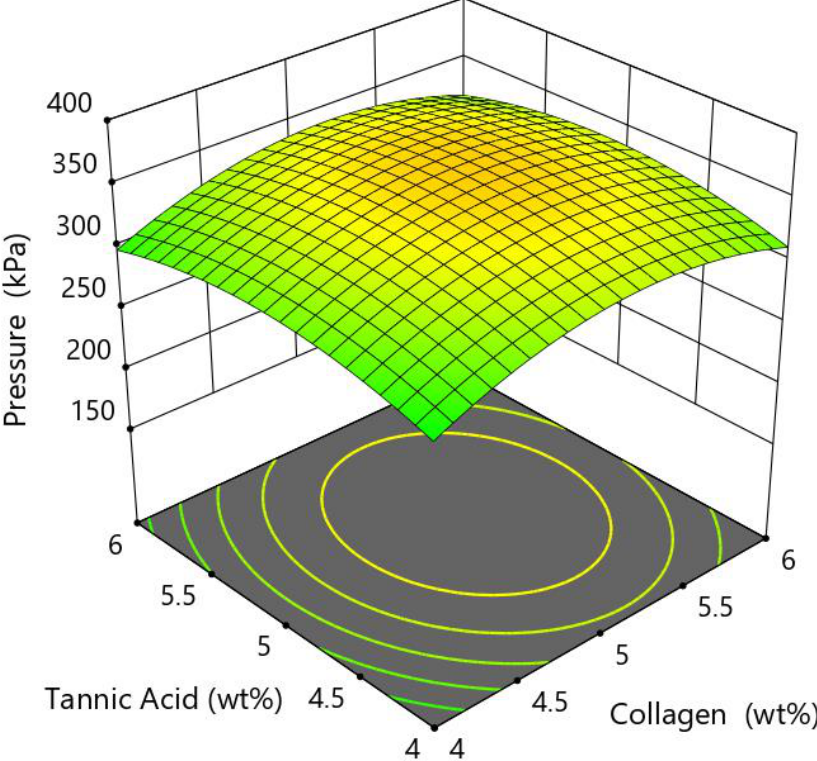
Figure 5. 3D response surface example to optimise the 3D bioprinting pressure.